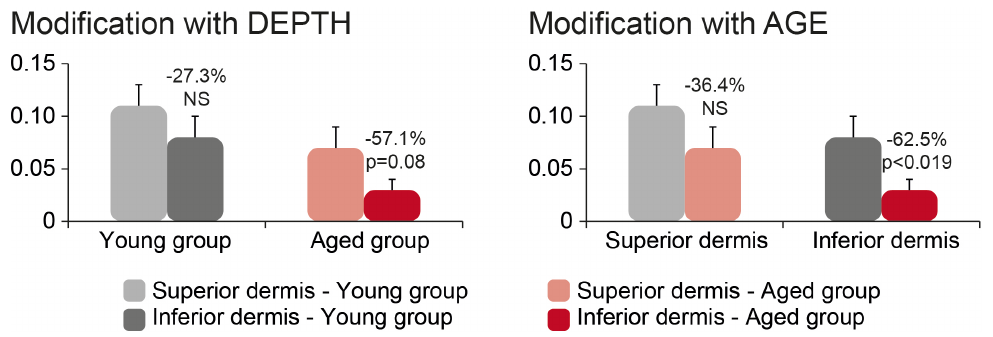
Figure 3. SHG-to-AF Aging Index of Dermis (SAAID) modification with depth of dermis and age. Measurements were performed on the volar forearm. The results are shown as mean ± SEM ( n = 30) and p values are indicated for the significant